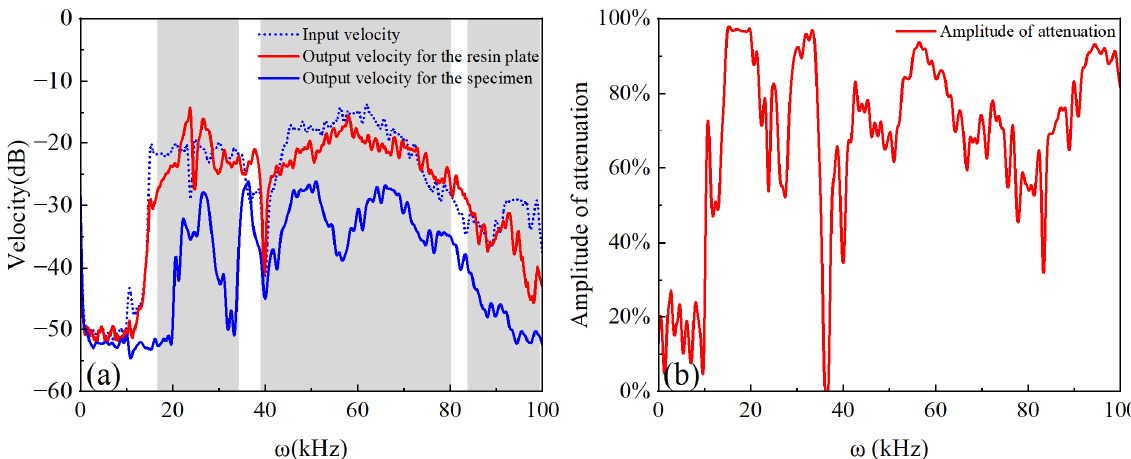
Figure 11. ( a ) The comparison of the input vibration velocity signal and output vibration velocity signal for the resin plate and the specimen within the range of the response frequency band, where the blue dashed line represents the input vibration velocity signal, the blue solid line represents the sample output vibration velocity signal and the red solid line represents the resin plate output vibration velocity signal; ( b ) the vibration signal amplitude attenuation for the specimen with the frequencies of 0~100 kHz.